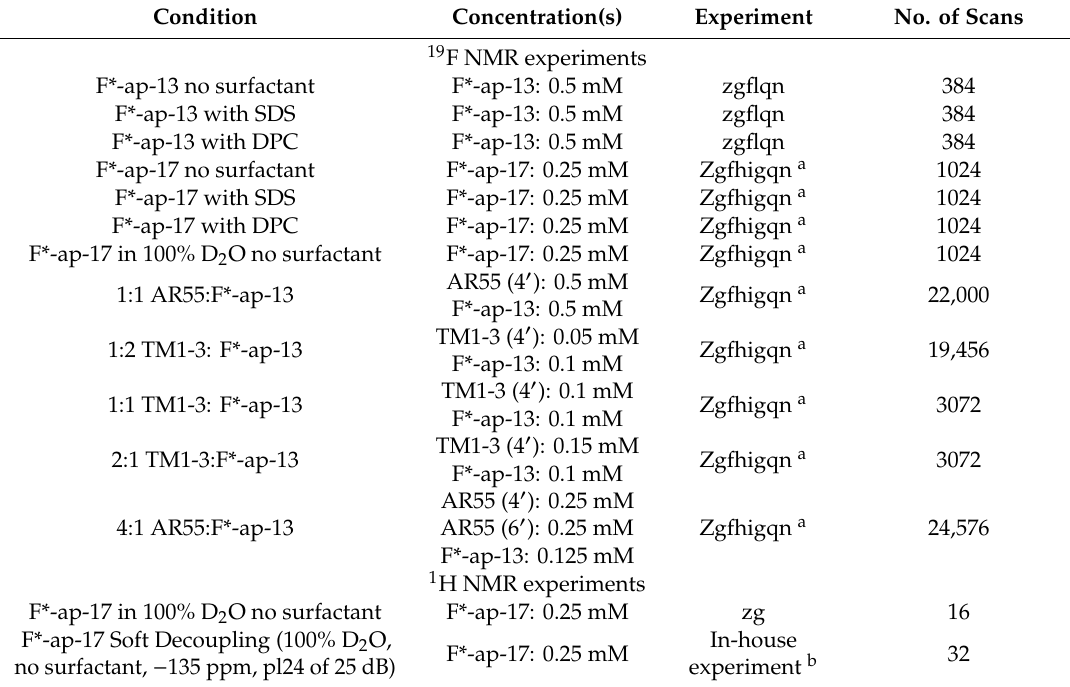
Table 3. Sample conditions and experimental parameters employed for 19 F and 1 H NMR data collection. Condition Concentration(s) Experiment No. of Scans 19 F NMR